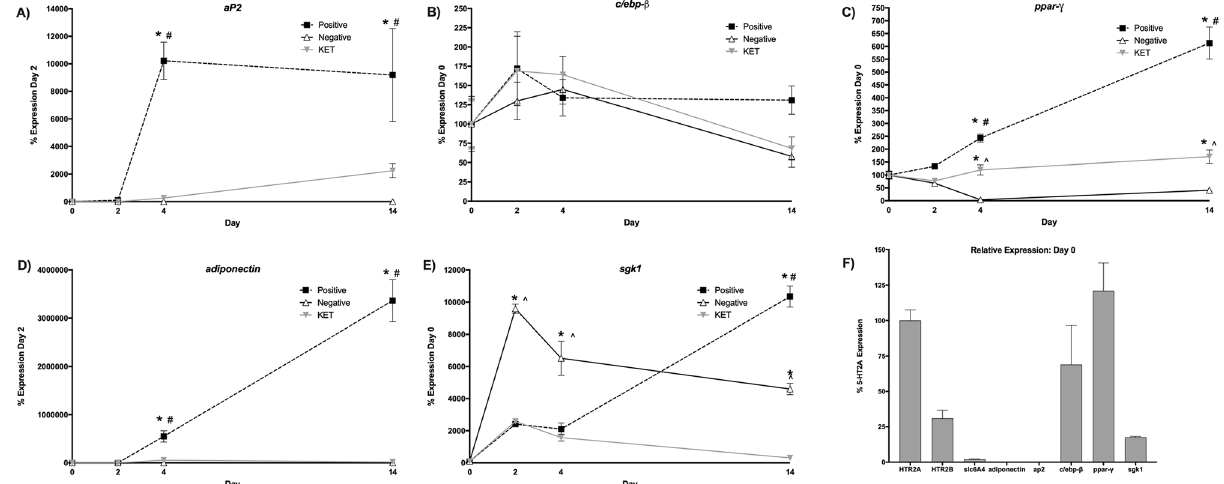
Figure 5. Expression of adipogenic genes are dynamic throughout the differentiation process, and are influenced by 5-HT 2A receptor blockade. “Positive” represents expression from controls that were induced to differentiate. “Negative” represents controls that were not induced, and were maintained in basal medium for 14 days. “KET” represents induced cells that were treated with 300 nM of Ketanserin at each step of the adipocyte differentiation process. (* p < 0.01 vs. negative control; # p < 0.01 vs. ketanserin treatment group; n = 3 biological replicates per treatment, with 3 technical replicates per biological replicate per gene expression data point; analysis of variance (ANOVA) with Tukey’s post hoc test). Ketanserin significantly blocks differentiation- induced expression of ap2 ( A ), ppar-γ ( C ), adiponectin ( D ), and sgk-1 ( E ), but does not significantly affect c/ ebp - β expression ( B ). ( F ) aP2 , c/ebp - β , ppar-γ , adiponectin, HTR2A , HTR2B , SLC6A4 (serotonin transporter; SERT) , and sgk-1 expression was determined in human primary subcutaneous preadipocytes by QPCR. Relative expression of these genes was analyzed using the HTR2A expression level as 100%. All expression experiments were performed in human primary subcutaneous preadipocyte cells at passage